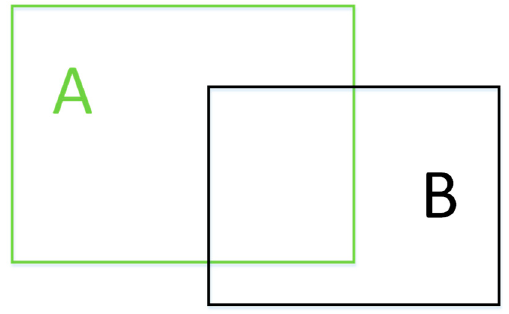
Figure 10. Intersection-over-union (IoU).